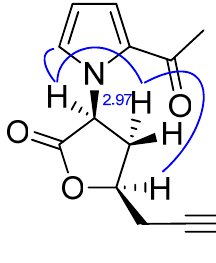
Figure 3. Key NOE correlations (curve) in